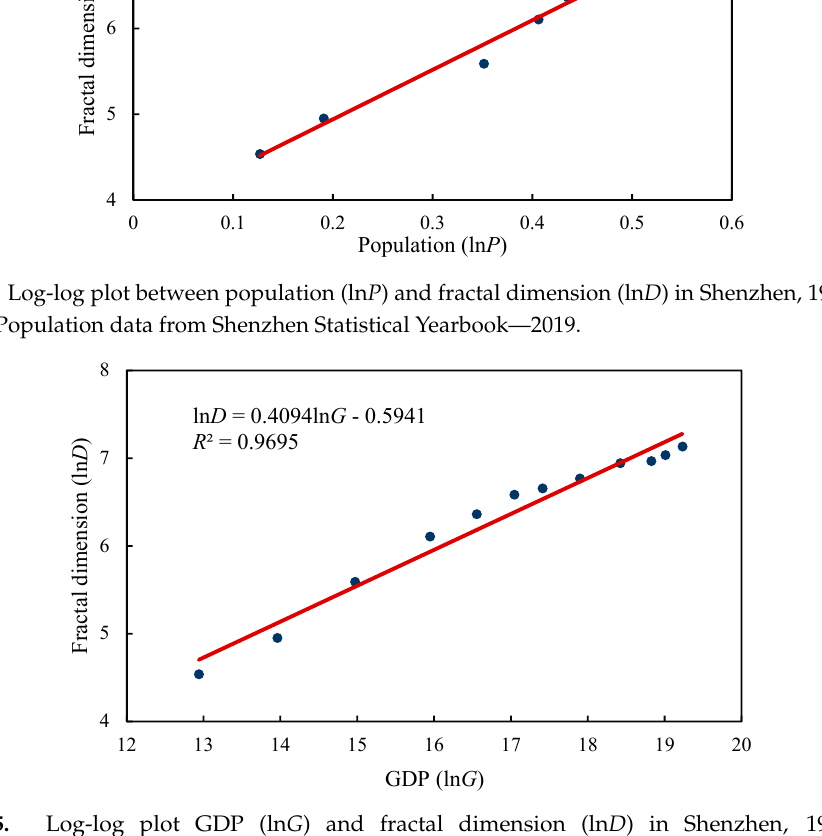
Figure 5. Log-log plot GDP (ln G ) and fractal dimension (ln D ) in Shenzhen, 1986–2017. Source: Population data from Shenzhen Statistical Yearbook—2019.